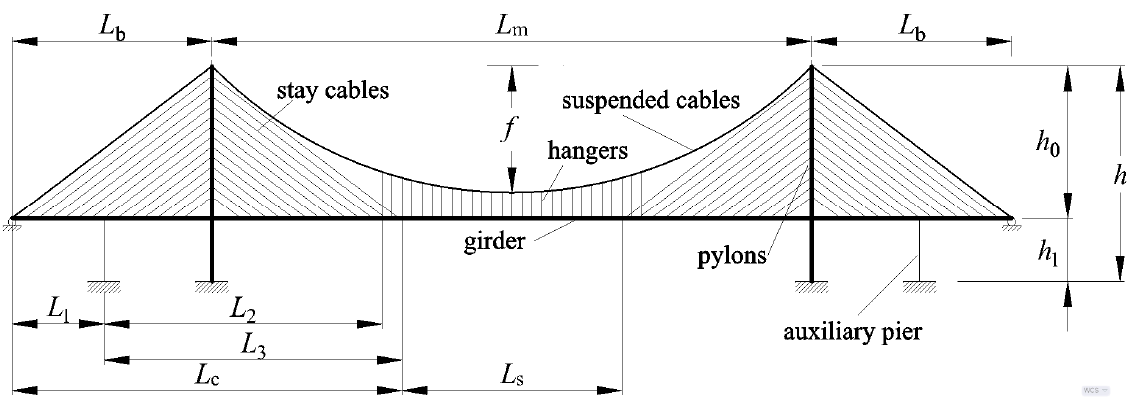
Figure 1. Structural members in the cable-stayed suspension bridge.